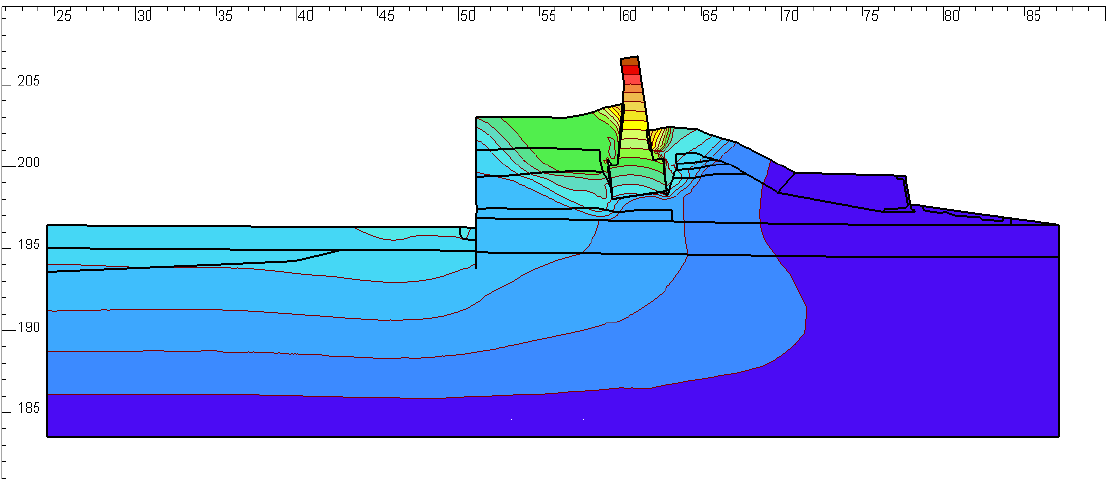
Figure 13: Failure mode, before the flood and in the descending phase of the flood. Fig. 13 Failure mode, before the flood and in the descending phase of the flood.